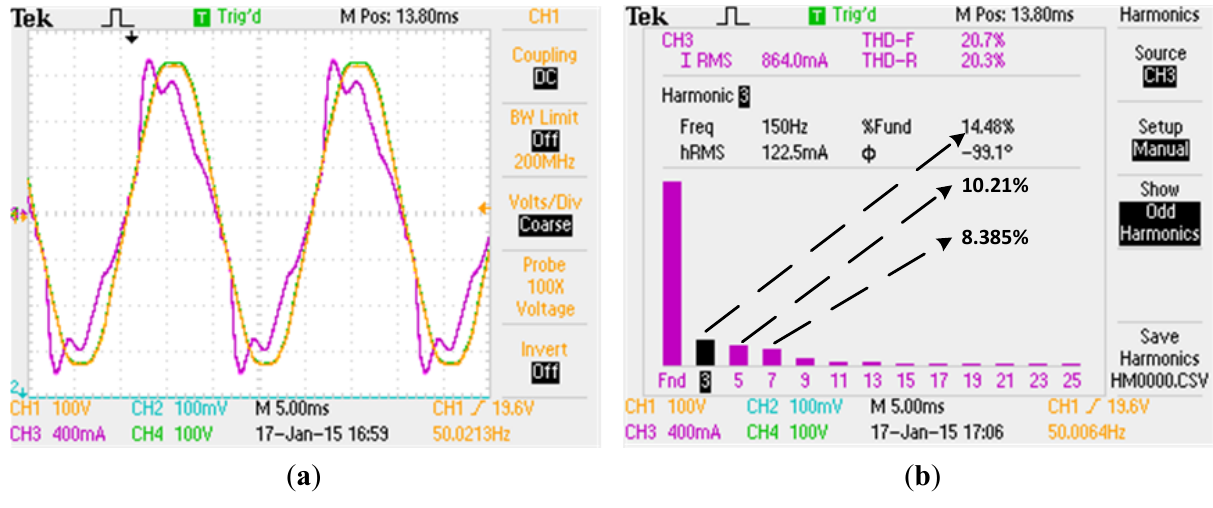
Figure 8. ( a ) Grid’s voltage and current waveforms before harmonic compensation; ( b ) Grid’s current harmonic spectrum before harmonic compensation.